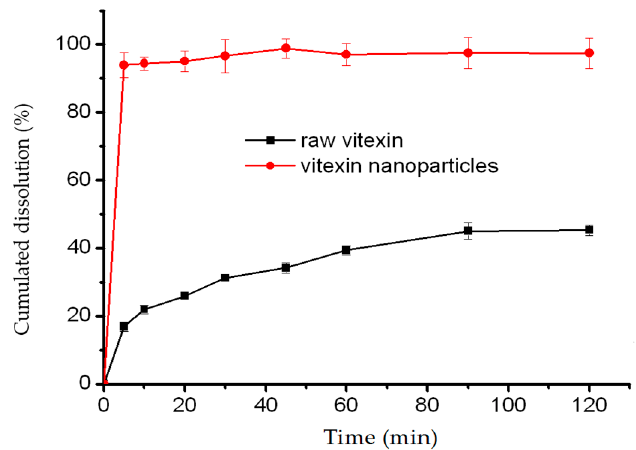
Figure 9. Dissolution profiles of raw vitexin and vitexin nanoparticles.